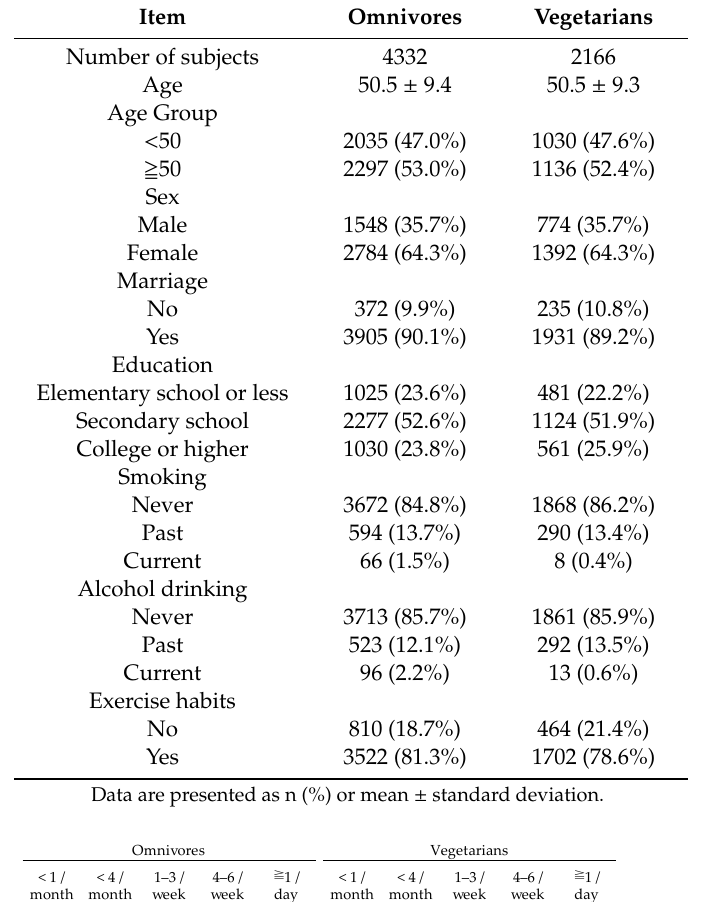
Table 1. Demographic and lifestyle characteristics of vegetarians and omnivores.